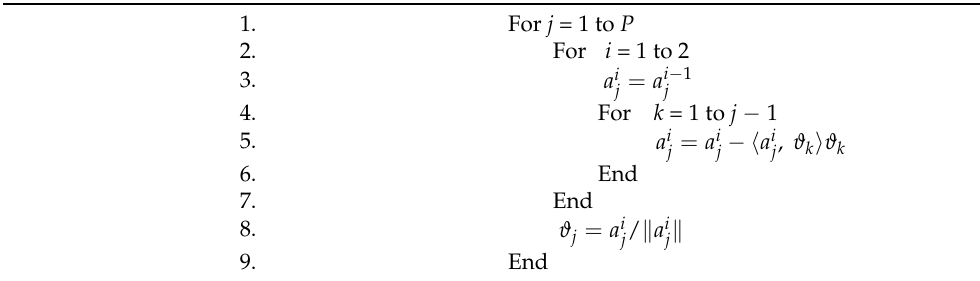
Table 1. Illustration of the modified Gram-Schmidt algorithm with the reorthogonalization [37]. Reprinted from [37], Copyright (2005), with permission from